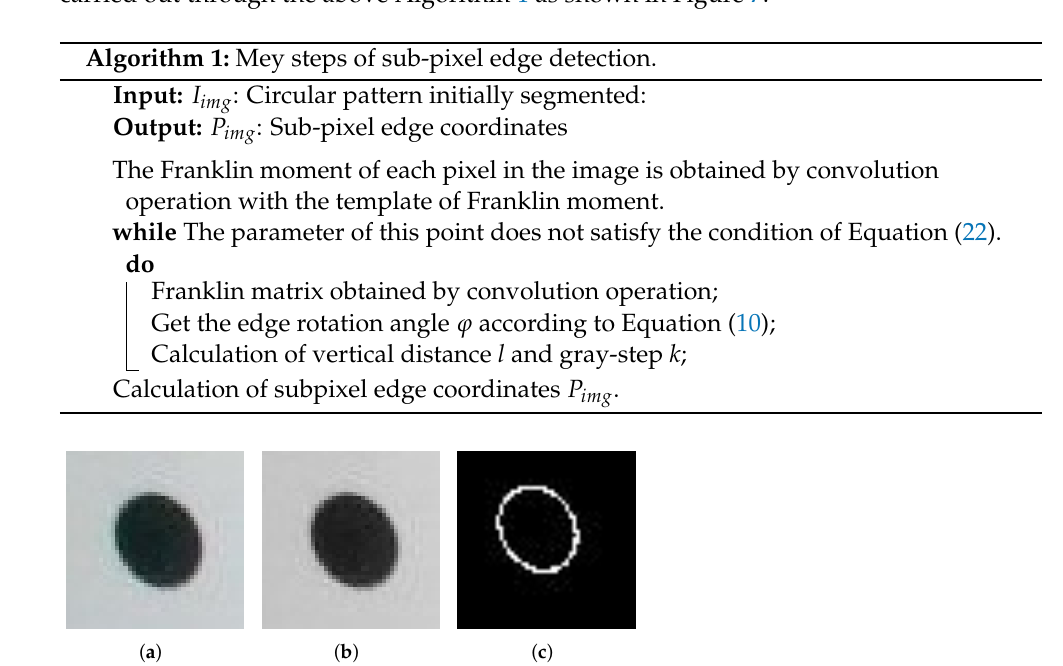
Figure 7. Subpixel edge extraction of circular calibration pattern. ( a ) Original image, ( b ) Grayscale, ( c ) Edge